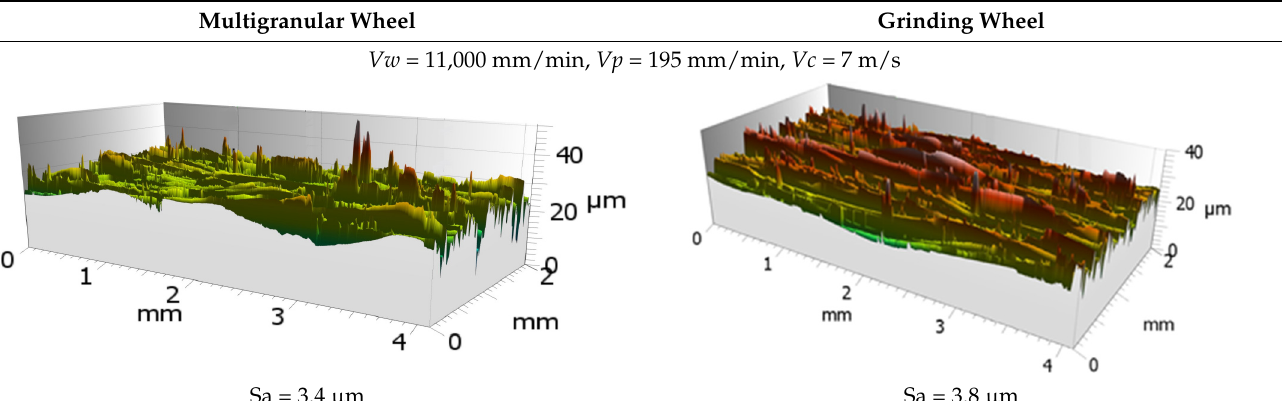
Table 6. Representative stereometric images obtained with multigranular and grinding wheels.